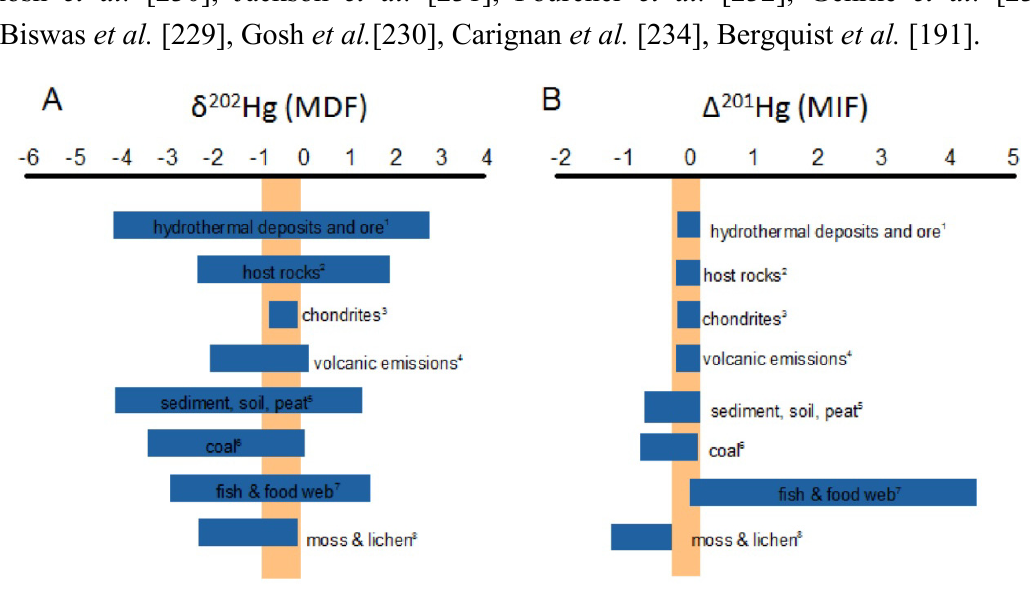
Figure 14. Summary of published Hg isotopic data (from Bergquist and Blum, [191]). The horizontal bars represent range in mass-dependent fractionation ( A ) and mass-independent fractionation ( B ). The vertical bars represent the estimated crust- and mantel-derived